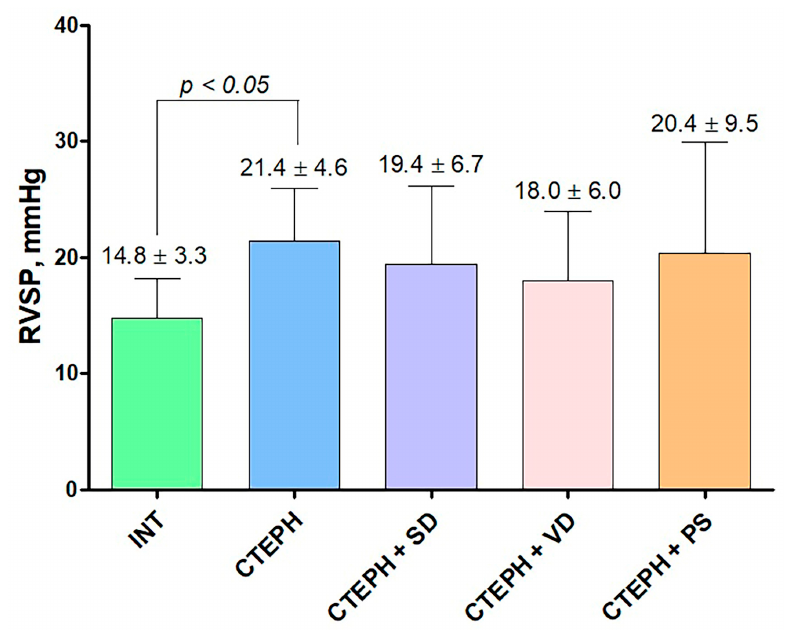
Figure 3. Right ventricular systolic pressure (RVSP) measured by RV apical puncture 6 weeks after microspheres administration. INT—intact animals (n = 13), CTEPH—chronic thromboembolic pul-